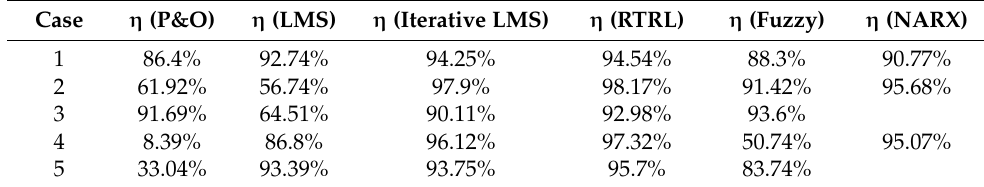
Table 3. Maximum efficiency obtained for the simulated control